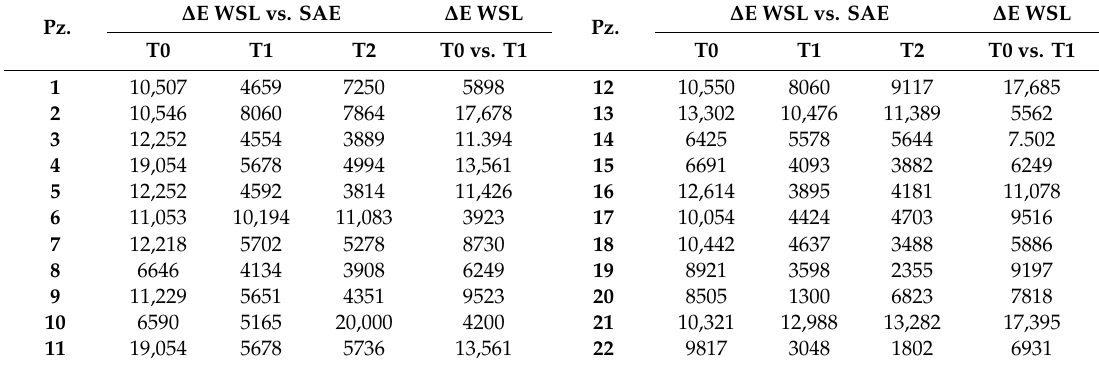
Table 2. ∆ E (WSL vs. SAE) at T0, T1, and T2, and ∆ E WSL (T0 vs. T1) for each patient.